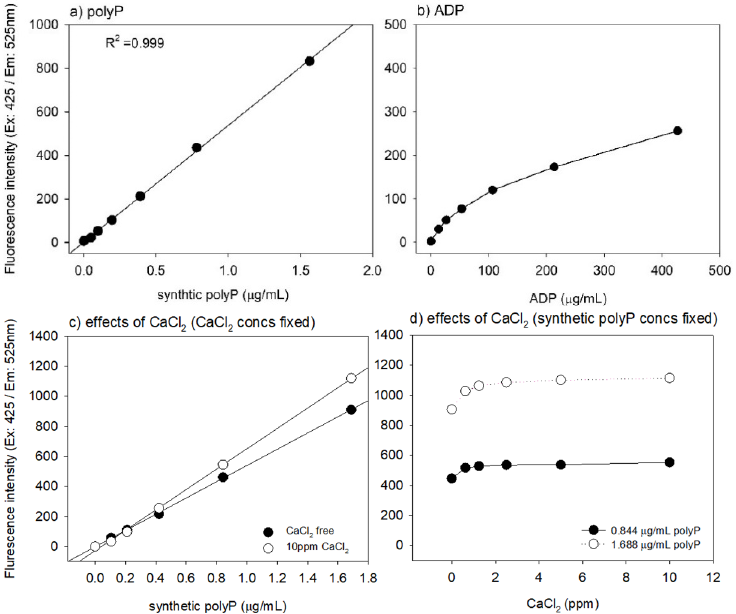
Figure 2. Standard curves for DAPI-reactive fluorescence intensity against synthetic polyP and ADP. ( a ) PolyP: Linear regression is observed in a wide range of polyP concentration. ( b ) ADP: Fluorescence signals are relatively lower even at higher concentrations; the regression is not expressed by a line. ( c , d ) Effects of exogenously added CaCl 2 on polyP quantification. Under the conditions of fixed concentrations of CaCl 2 ( c ) and polyP ( d ), DAPI-reactive fluorescence intensity against synthetic polyP was